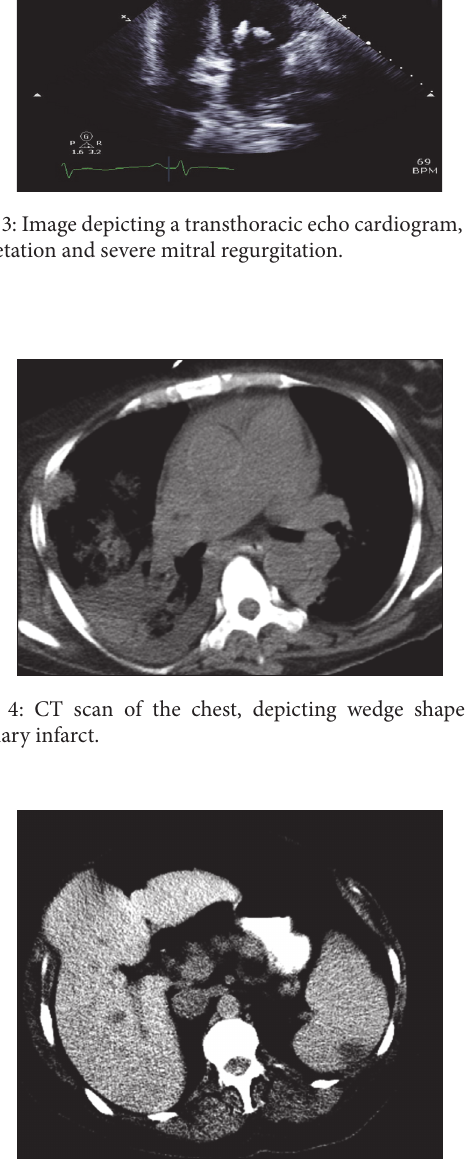
Figure 5: CT scan of the abdomen, depicting splenic